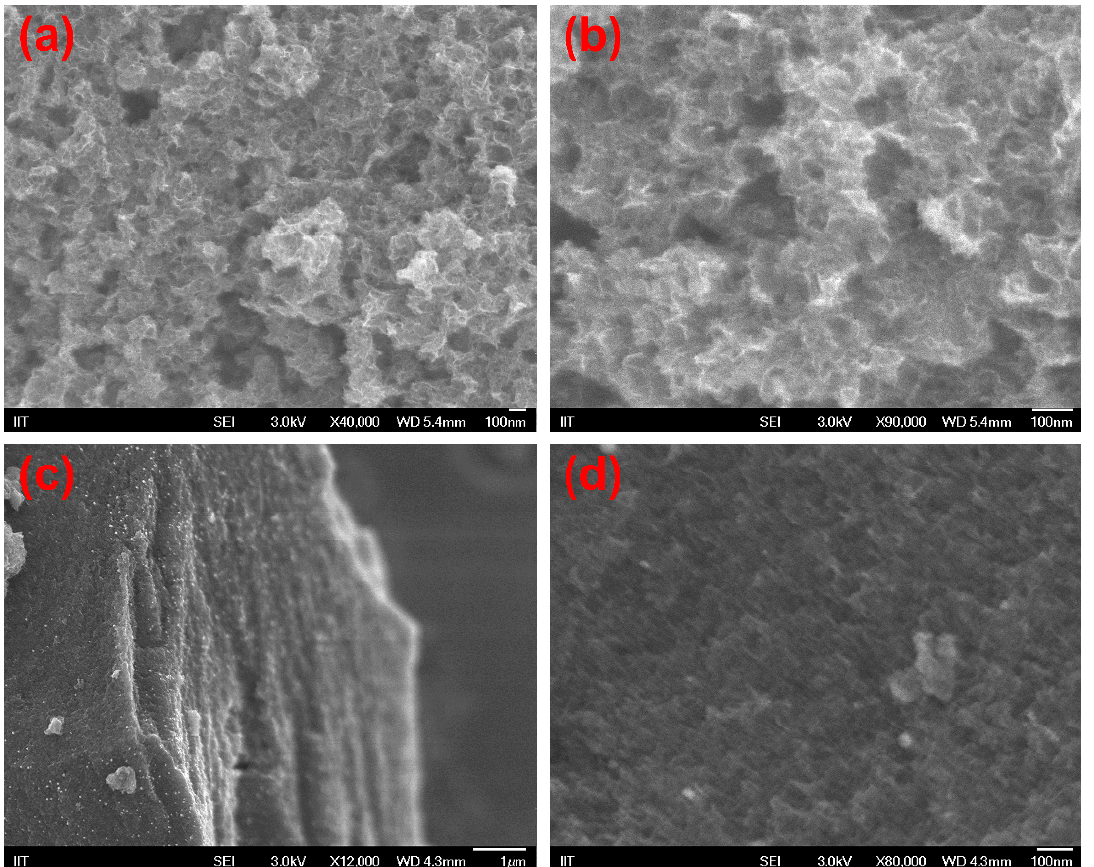
Figure 2. Scanning electron microscopy (SEM) images of PC–MF and PC–KOH. ( a ) PC–MF, ( b ) PC–MF, ( c ) PC–KOH, and ( d ) PC–KOH.